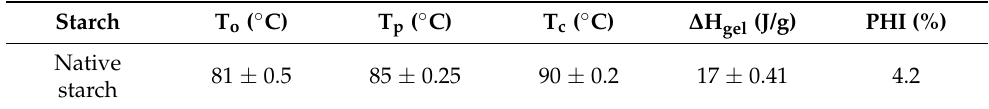
Table 4. Mean ± standard deviation of the physicochemical characteristics of Talisia floresii Standl native starch.